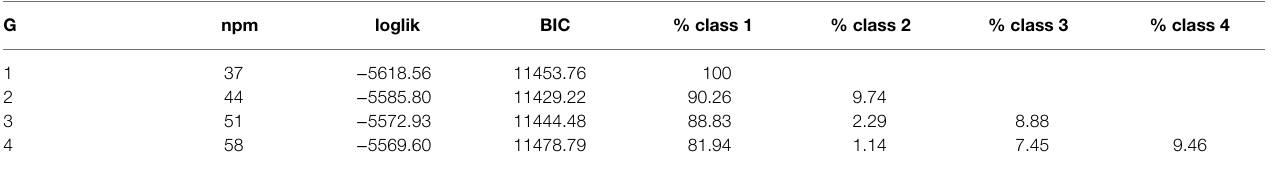
G, number of estimated groups; Loglik, log likelihood; npm, number of parameters; and BIC, Bayesian Information Criterion.